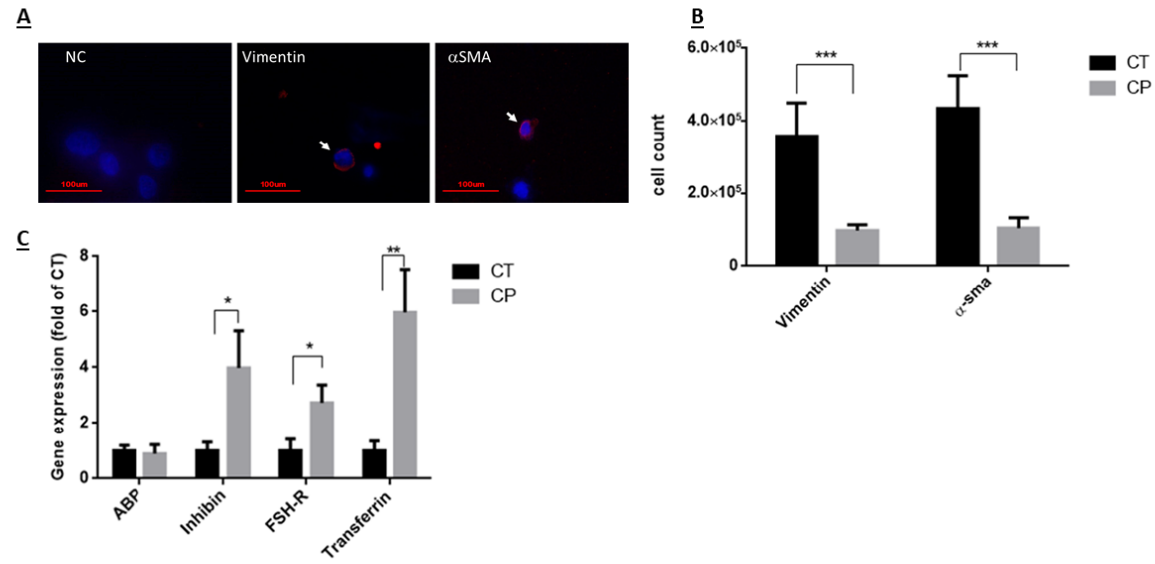
Figure 3. Effect of CP on the number of Sertoli and peritubular cells and on the functionality of Sertoli cells from immature mice: Cyclophosphamide (CP)- or PBS-treated mice (control, CT) were i.p injected as described in Figure 1. Ten days post- treatment, testes were removed, seminiferous tubules were separated, and cells were enzymatically isolated from the seminiferous tubules. Sertoli cells and peritubular cells were identified by immunofluorescence staining using specific antibodies for each cell type (vimentin—a marker for Sertoli cells and α -SMA—a marker for peritubular cells) and the secondary antibody Cy3 (red color) ( A ). DAPI (blue color) stained the nucleus of the cells ( A ). The identified cells were counted and their number/testis was evaluated ( B ). Moreover, RNA was extracted from cells isolated from seminiferous tubules of CT or CP-treated mice, and examined by qPCR analysis for the expression levels of factors known to be produced by Sertoli cells [androgen binding protein (ABP), inhibin, FSH-receptor (FSH-R), transferrin], using specific primers for each factor ( C ). Arrows indicate the stained cells. *— p < 0.05, **— p < 0.01, and ***— p < 0.001.